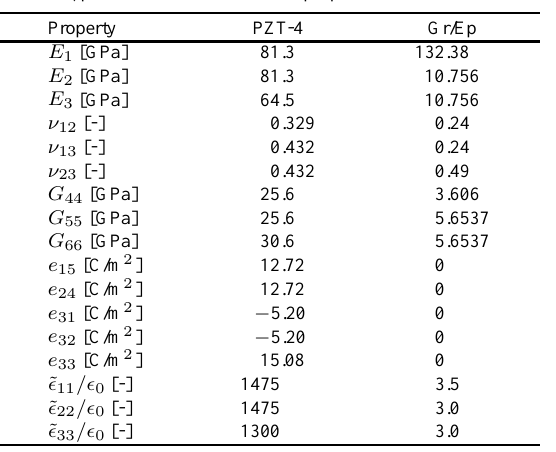
Table 6 Elastic, piezoelectric and dielectric properties of used